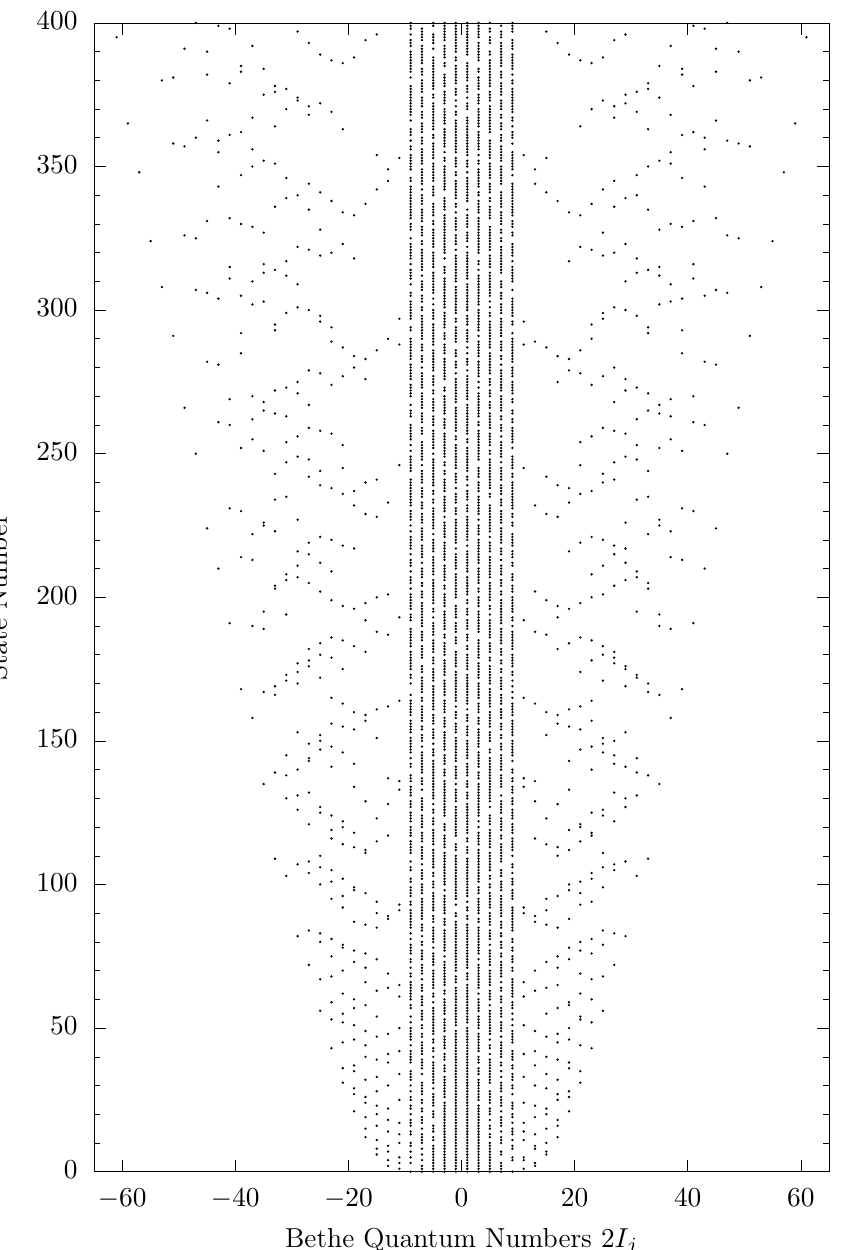
} in the first 400 states generated via pref- j = 20 → c = 10 i f